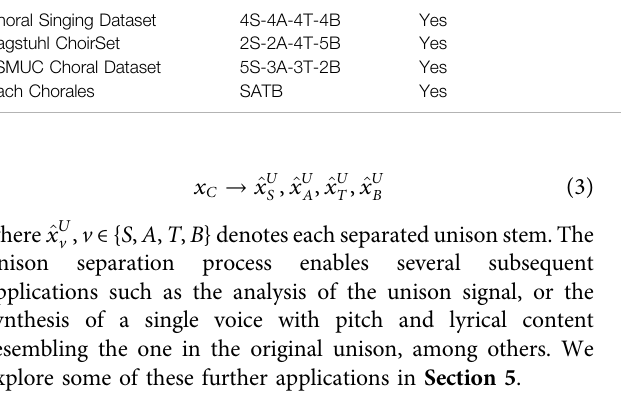
TABLE 1 | Summary of the multitrack datasets of ensemble singing we use in this project. The reported durations refer to the total recording duration, not considering multiple stems per recording. Dataset Voices and nb.